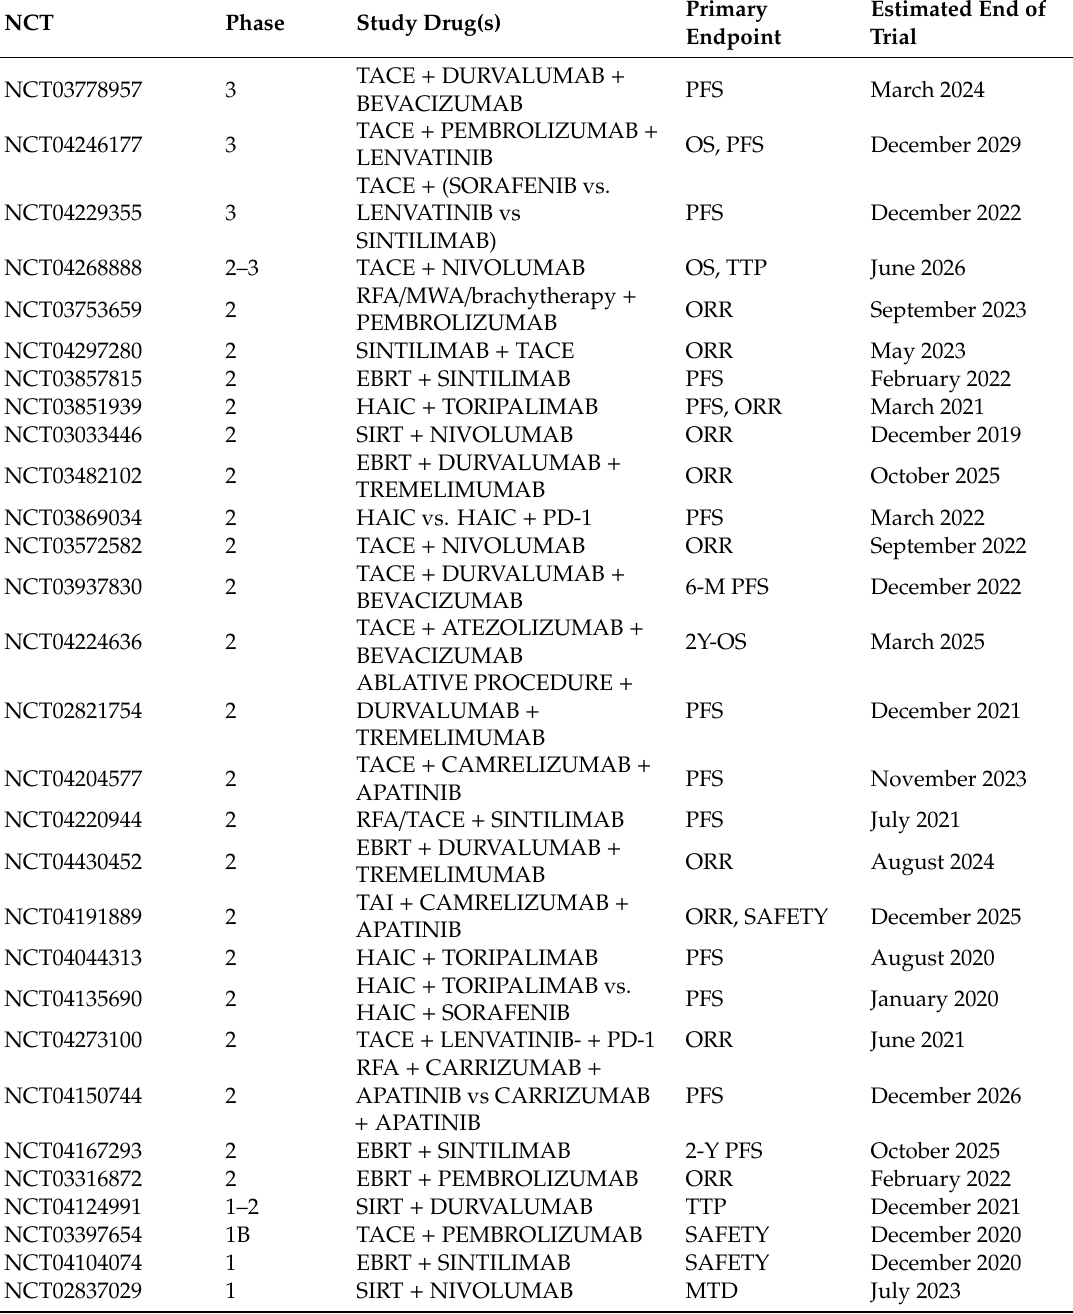
Table 5. Ongoing clinical trials exploring immune checkpoint inhibitors in combination with local